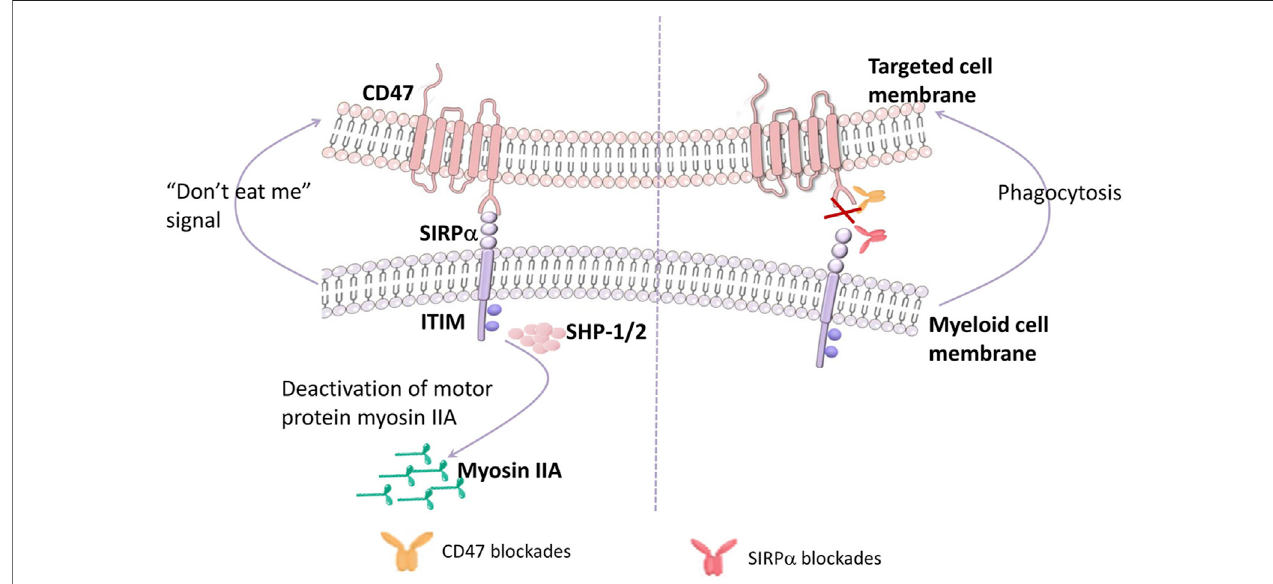
FIGURE1| CD47interactswithSIRP α .The N-terminal Ig-like extracellulardomain ofSIRP α onmyeloid cellsbindingtotheN-terminalIgV-like extracellular domain of CD47 on targeted cells induces the phosphorylation of ITIM of SIRP α , then recruits and activates the protein tyrosine phosphatases, especially Src homology 2 (includingSHP-1andSHP-2).UponactivatedSHP-1/2engagement,myosinIIAdephosphorylationOccurs,releasingthe “ don ’ teatme ” signal,leadingtoaninhibitionof phagocytosis. On the contrary, inhibiting the CD47-SIRP α pathway activates the phagocytosis by myeloid cells.